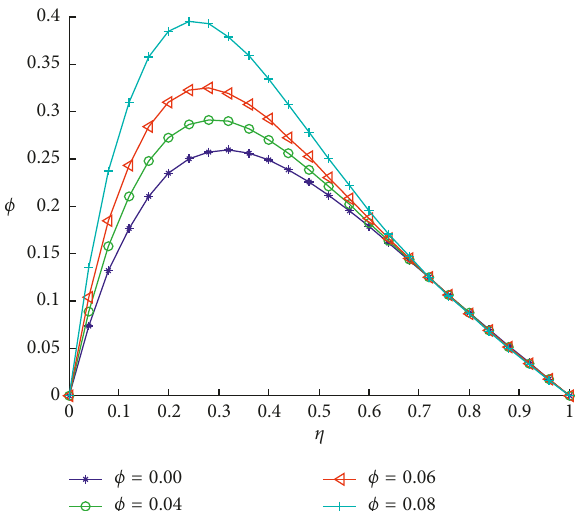
Figure 19: Effect of nanoparticle volume fraction on the con- Nb centration profile when A 2 , S 1 ,Nt 0 . 2 , β 0 . 05 ,M (cid:31) (cid:31) (cid:31) (cid:31) (cid:31) Pr 0 . 5 ,Le 1 . 0 , c 0 . 1 , and C (cid:31) (cid:31) (cid:31) (cid:31)